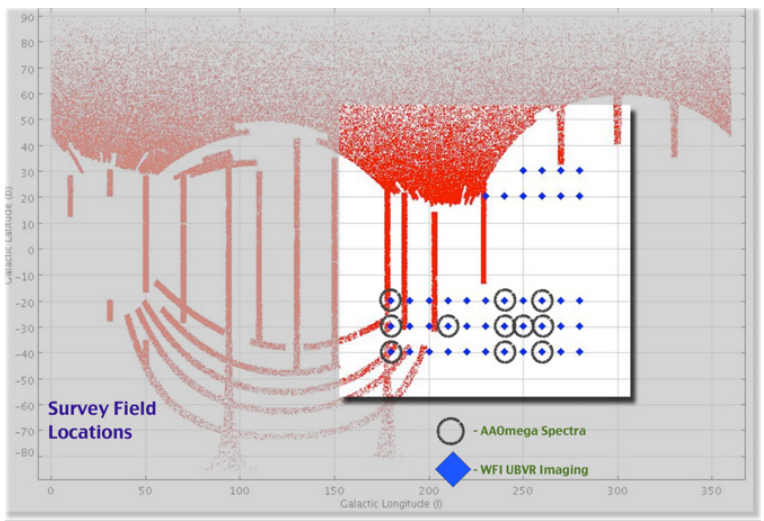
Figure 1. Survey field locations shown in Galactic Coordinates with blue diamonds for the photometric fields and grey circles for the spectroscopic fields. The red points show the footprint of the Sloan Digital Sky Survey and emphasize how this survey extends into regions not reachable from the North.